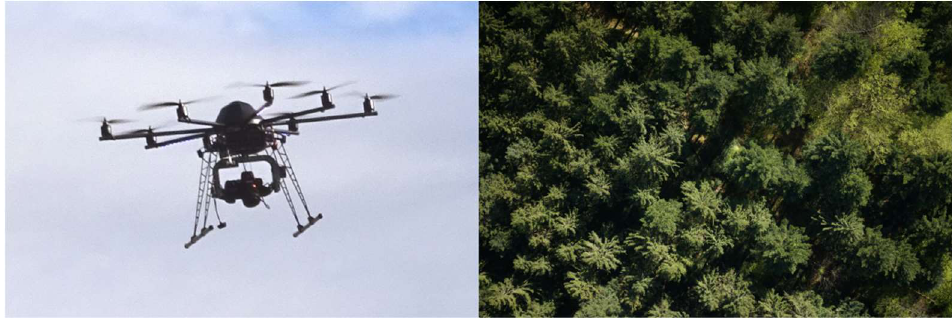
Figure 3. Image of the aerial system ( left ) and canopy-top remotely sensed image during flight ( right ).